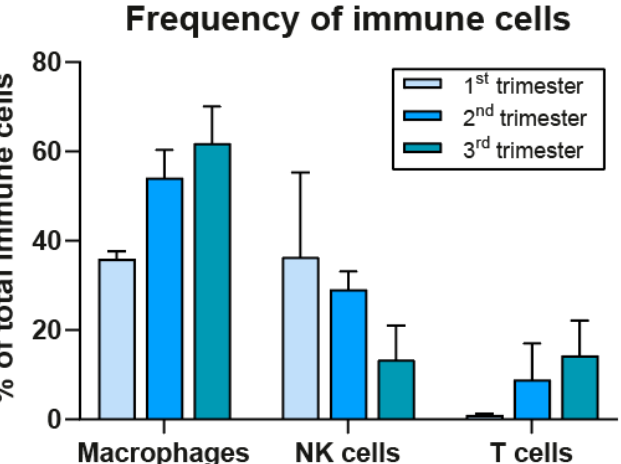
Figure 3. Immune cell frequencies at the decidua basalis during pregnancy. Frequencies were determined by imaging mass cytometry in decidua basalis at first, second, and third trimester (median with SD; adapted from Krop et al. [40]).